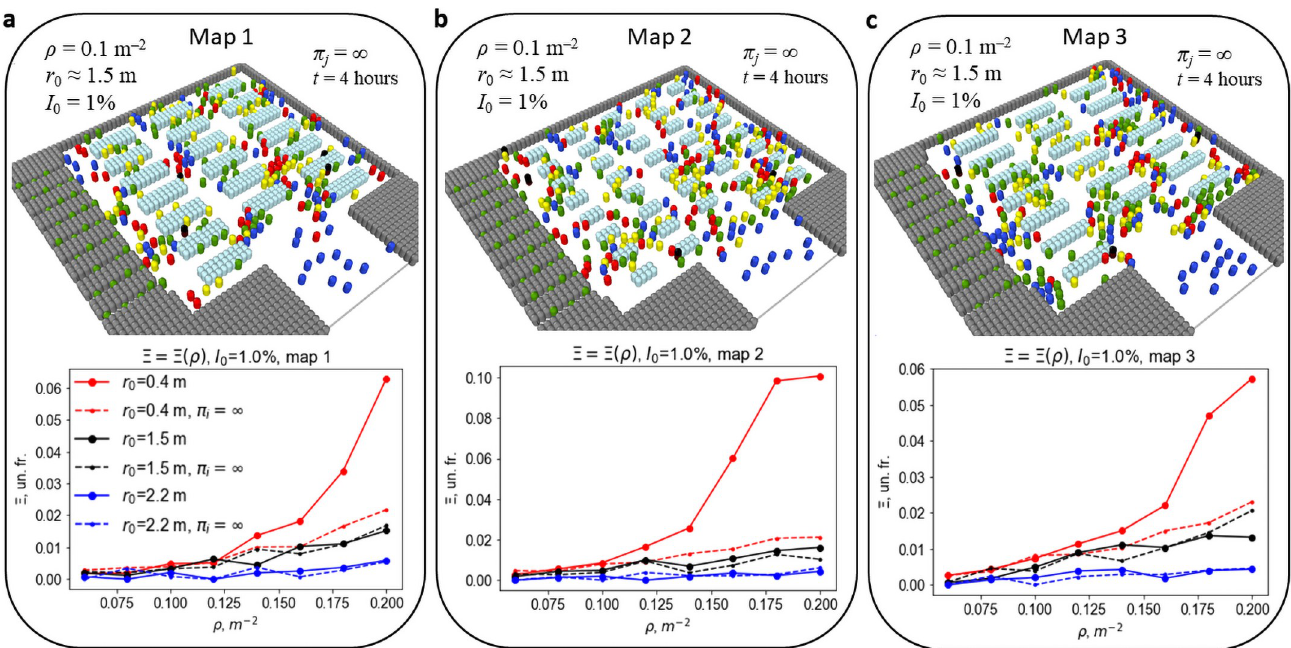
Fig 6. Probability of getting the infection, visiting a model supermarket as a function of ρ and r 0 as parameter. The results are presented for different supermarket models: map 1—base ( a ), map 2 ( b ) and map 3 ( c ). Schemes of all the supermarket models are presented in S2–S4 Figs in S1 Appendix. Dashed lines represent results, obtained for simulations without a changing of purchasers behavior in crossroads to Rules B (as if purchases list is infinite π i = 1 ). Significant increase of X with growing ρ is observed in all three cases for smallest social distance r 0 = 0.4 m and turned on Rules B. This result can be explained by comparatively large local density of customers near the cashier